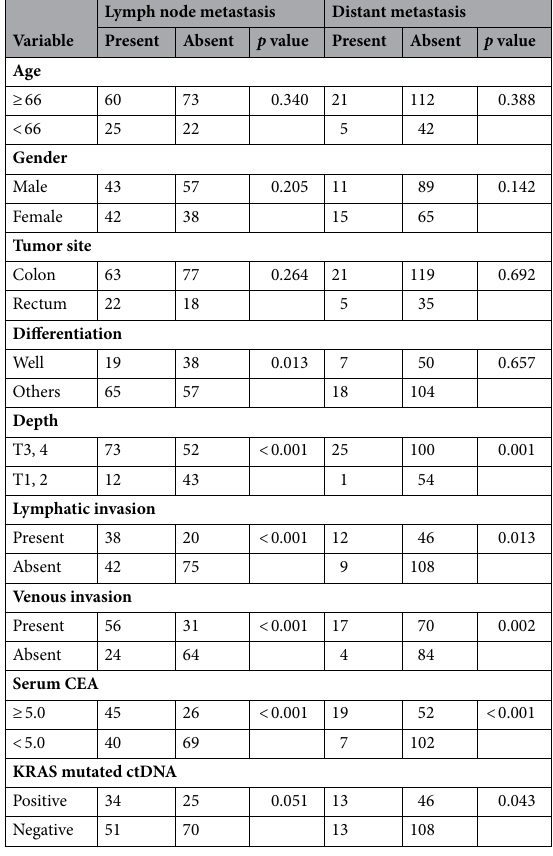
Table 2. Univariate analysis of lymph node metastasis and distant metastasis. Well well differentiated adenocarcinoma; others moderately differentiated, poorly differentiated, mucinous and papillary adenocarcinoma.